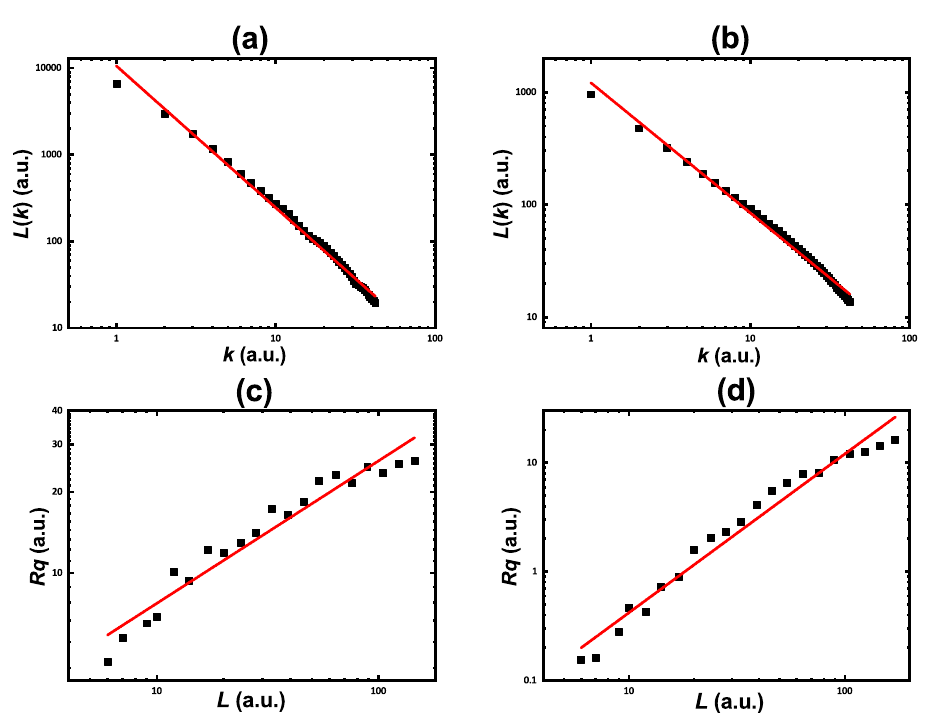
Figure 2. Four typical double logarithmic curves of ( a ) raw signal with Higuchi algorithm, ( b ) denoised signal with Higuchi algorithm, ( c ) raw signal with RSE-f1 algorithm, and ( d ) denoised signal with RSE-f1 algorithm.